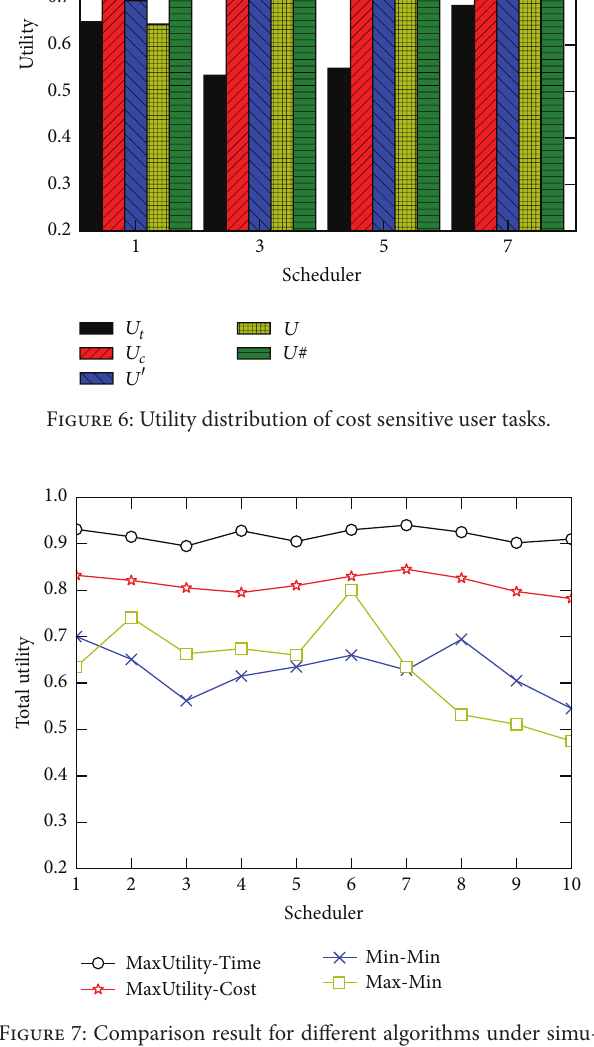
Figure 7: Comparison result for different algorithms under simu- lating